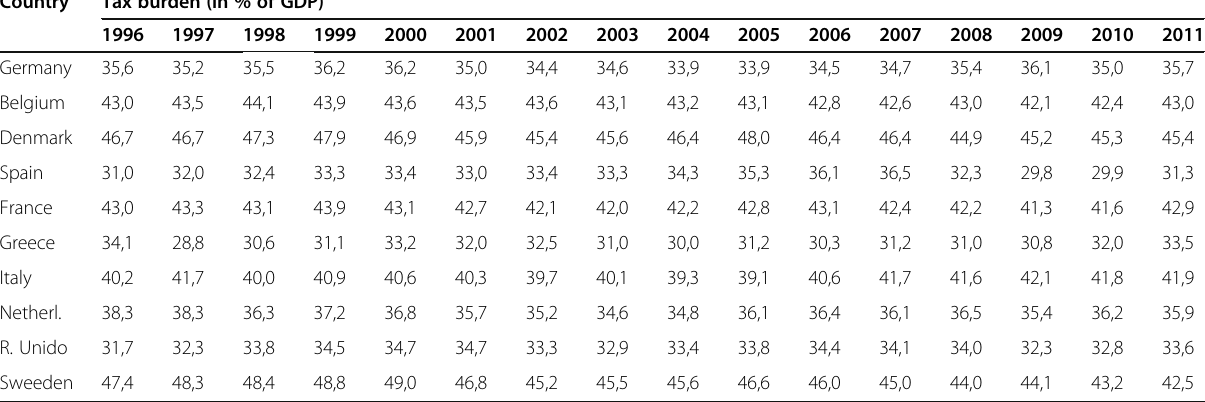
Table 4 Tax burden in selected EU countries, 1996 – 2011 (in % of GDP) Country Tax burden (in % of GDP)